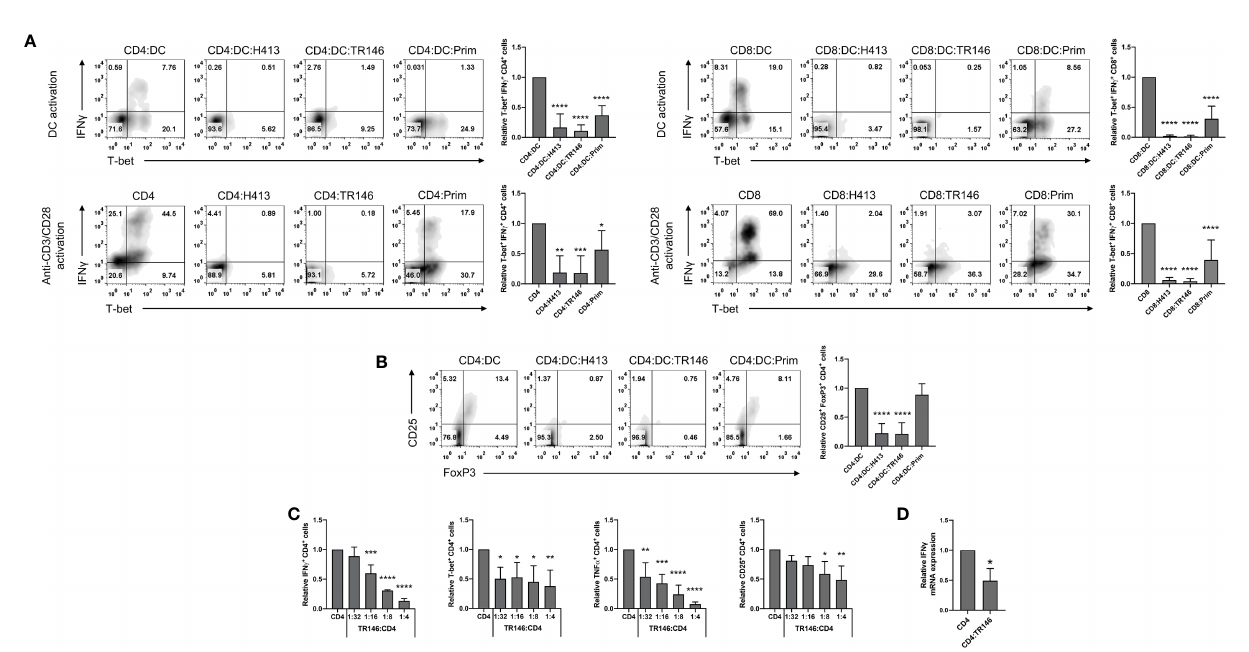
FIGURE 1 | OECs restrain T cell activation and polarization. (A) CD4 and CD8 T cells were activated by allogenic LPS-matured DCs for 6 days (top) or with anti- CD3/CD28 antibodies for 48 h (bottom), both in the presence or not of H413, TR146 or primary (Prim.) OECs. T-bet and IFN g expression was analyzed by fl ow cytometry in CD4 and CD8 T cells. (B) Flow cytometry analysis of CD25 and FoxP3 expression in CD4 T cells activated for 6 days by allogenic LPS-matured DCs and cultured alone or with H413, TR146 or primary (Prim) OECs. In both panels, results are shown as the percentage of CD4 T cells expressing the mentioned markers from a representative experiment (density plots) and relative to CD4 T cells alone when considering all experiments (bar graphs). (C) Percentage of CD4 T cells expressing T-bet, CD25, IFN g and TNF a as determined by fl ow cytometry relative to CD4 T cell alone. CD4 T cells were activated by anti-CD3/CD28 beads and cultured alone or with TR146 cells for 48 hours with increasing TR146:CD4 cell number ratios. (D) Relative expression of IFNG mRNA from CD4 T cells as measured by RT-qPCR. CD4 T cells were activated by anti-CD3/CD28 beads and cultured alone or with TR146 cells for 48 hours. In all previous cases, CD4 T cells were re- stimulated with PMA and ionomycin for 4 hours before analysis. FACS gatings were adjusted by the use of mouse anti-IgG-PE and anti-IgG-APC antibodies. We plotted mean values with error bars corresponding to SEM. Statistically signi fi cant differences were obtained applying ANOVA tests (A-C) or two-tailed Student ’ s t tests for independent samples (D) . Signi fi cant differences (p < 0.05, p < 0.01, p < 0.001 or p < 0.0001) are noted as “ * ” , “ ** ” , “ *** ” , and “ **** ” , respectively. Data were obtained from a total of three independent experiments using samples from different